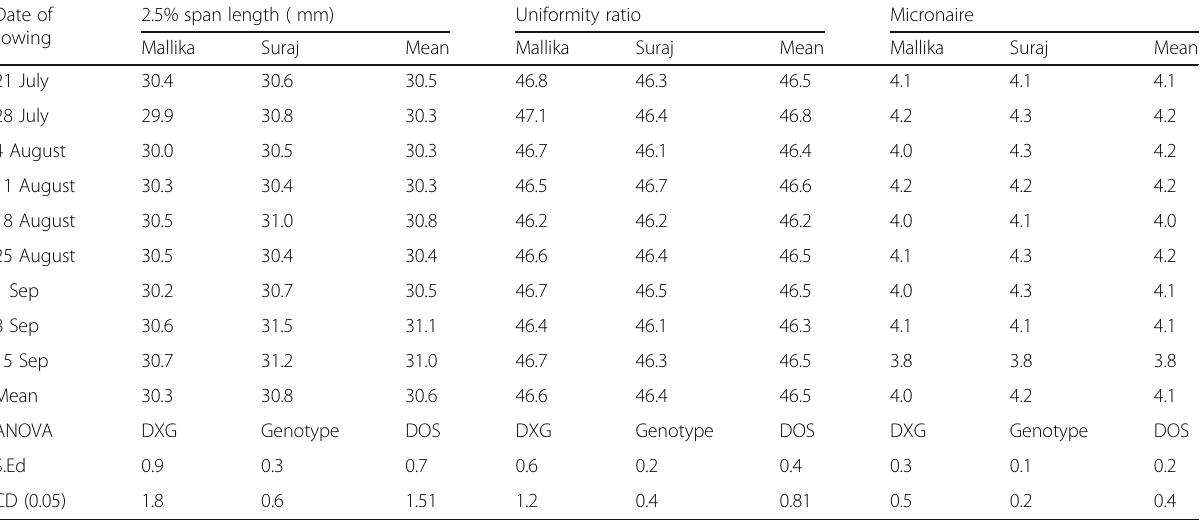
characters revealed that these were influenced little by genotypes (except strength (g/tex)) or planting time (Ta- bles 6 and 7). The combined results revealed that Suraj had a significantly higher fibre strength than Mallika BGII. Discussion Growth characters Growth characters include plant height (cm), number of bolls, number of monopodia and sympodia which were influenced significantly by genotypes and different dates of sowing. The highest significant record of the tallest plant (102.2 cm), number of bolls (28.8), number of monopodia (1.8) and number of sympodia (19.3) were